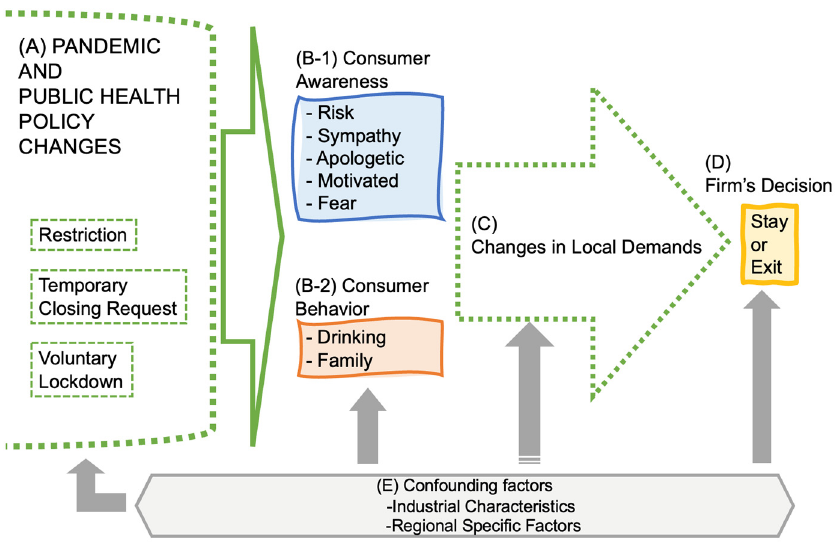
Figure 1. Basic model.